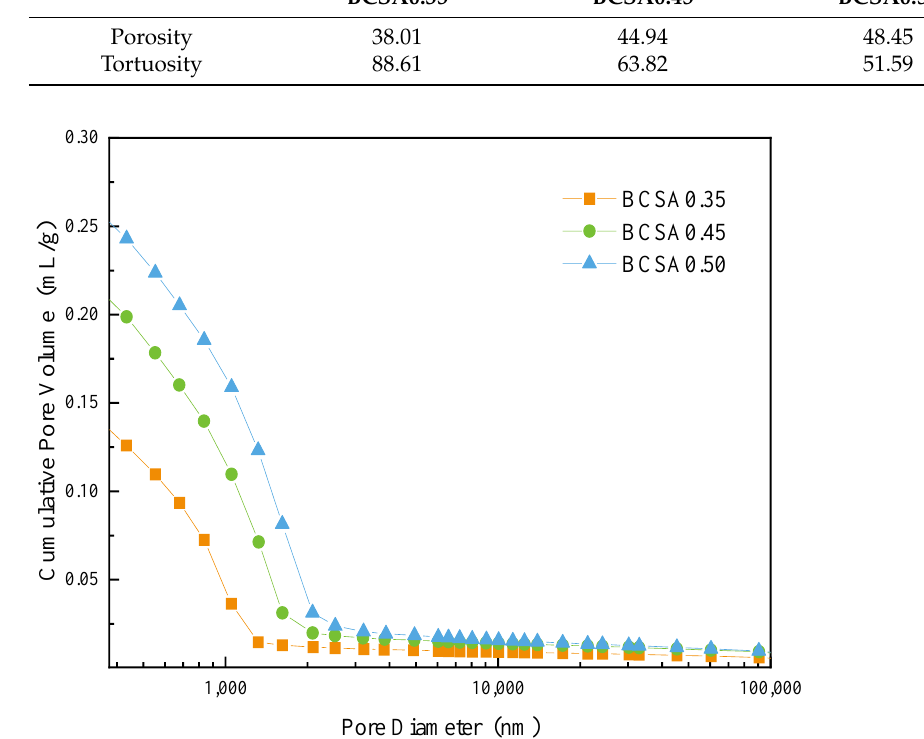
Figure 8. Pore size distribution of BCSA cement pastes with various w / c ratios at 28 d.